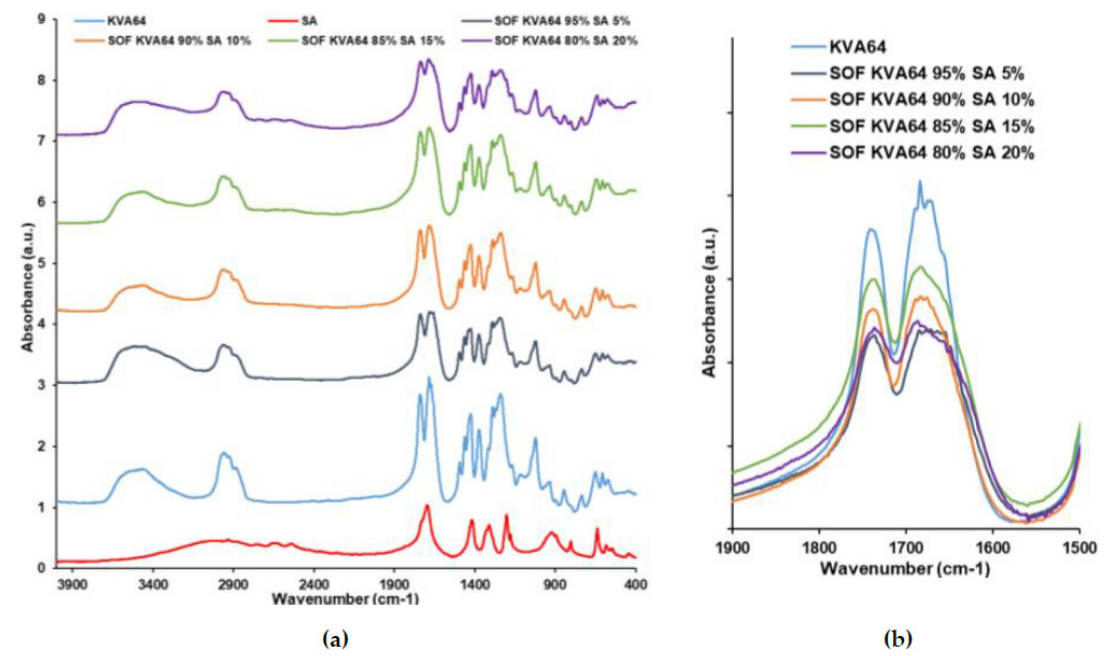
Figure 5. FTIR spectrums of KVA64, SA and printed SOFs: ( a ) from 400 to 4000 cm − 1 , ( b ) from 1500 to 1900 cm − 1 . The FTIR spectra of the SOFs prepared with KVA64, IbuNa and SA also showed a broadening of the C=O amide peak of copovidone (Figure 6b). Notably, although the C=O stretch peak of IbuNa at 1549 cm − 1 was found in all the SOFs, its intensity decreased with the proportion of succinic acid (Figure 6a), suggesting that a high content of SA promotes the amorphization of IbuNa.